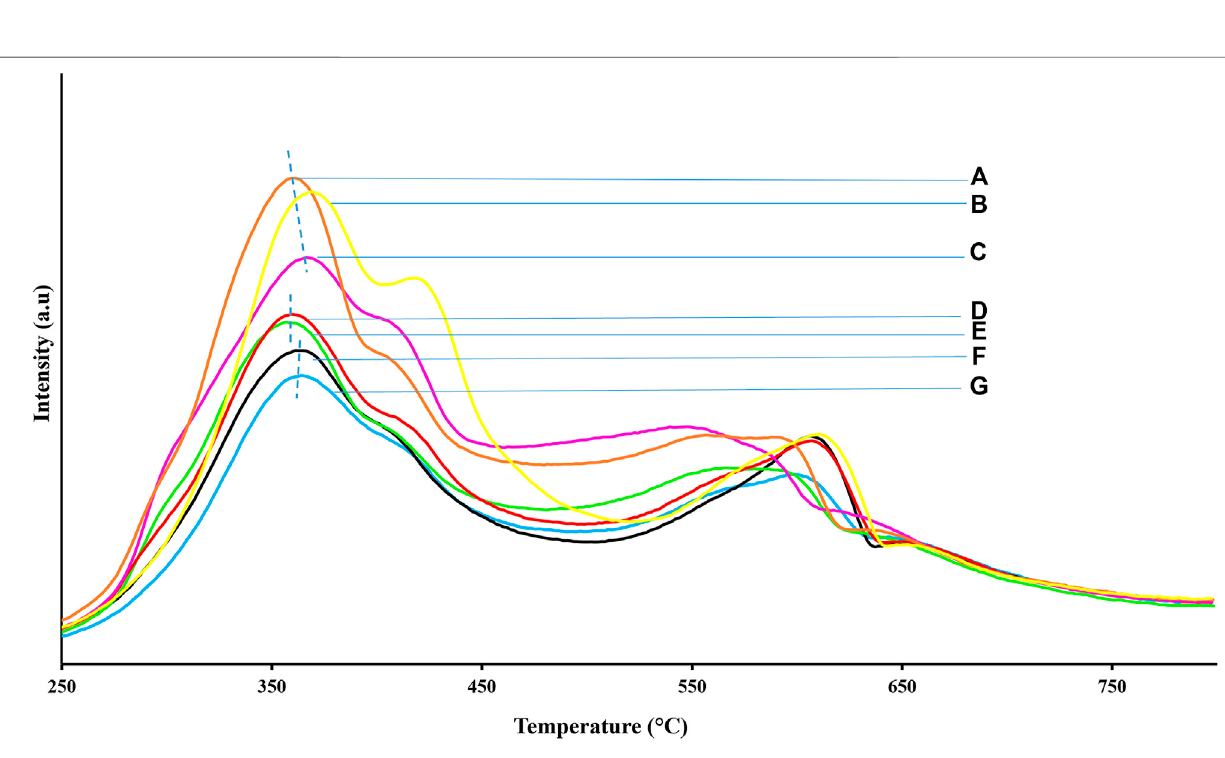
Frontiers in Chemical Engineering |